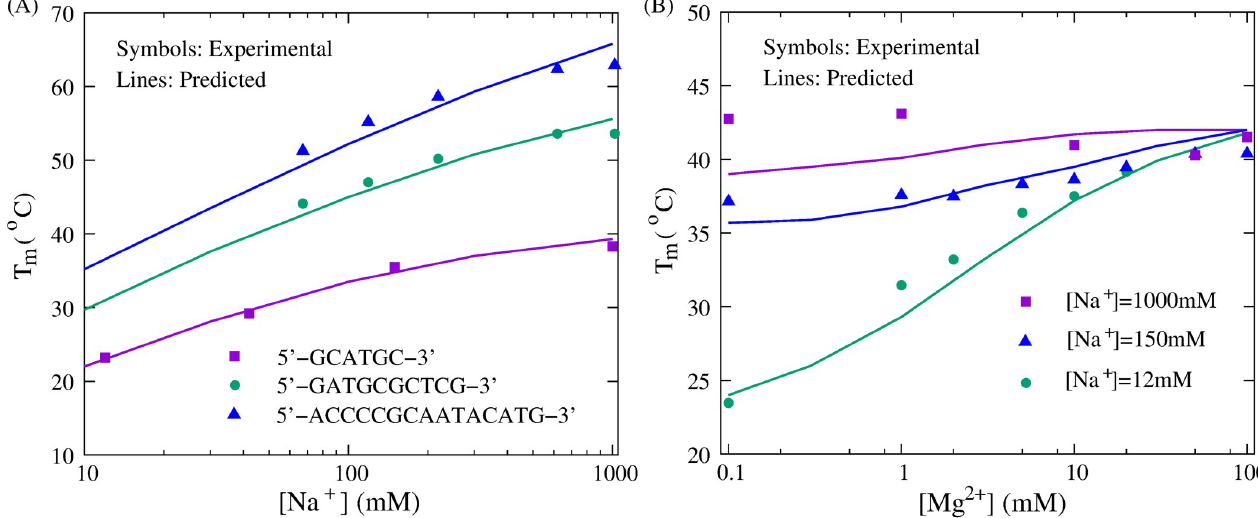
Fig 7. The comparisons of stability between predictions (lines) and experiments (symbols) for dsDNAs in monovalent/divalent ion solutions. (A) The melting temperatures ( T m ’s) as functions of [Na + ] for three dsDNAs with sequences of (GCATGC) 2 , (GATGCGCTCG) 2 , (ACCCCGCAATACATG) 2 from bottom to top, respectively. Symbols: experimental data [87,97].Lines: predictions from the present model. (B) The melting temperatures ( T m ’s) as functions of [Mg 2+ ] for the dsDNA with sequence of (GCATGC) 2 at different [Na + ]’s: 0.012M, 0.15M, and 1M from bottom to top, respectively. Symbols: experimental data [87]. Lines: predictions from the present model.